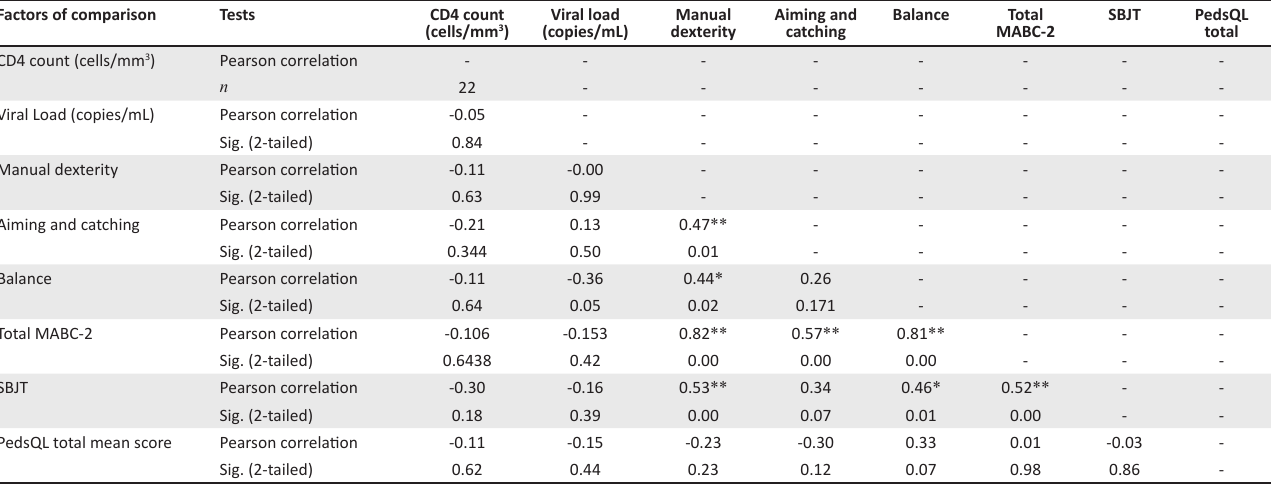
TABLE 5: Correlations between CD4 count, viral load and all outcome measures ( n = 30). † Factors of comparison